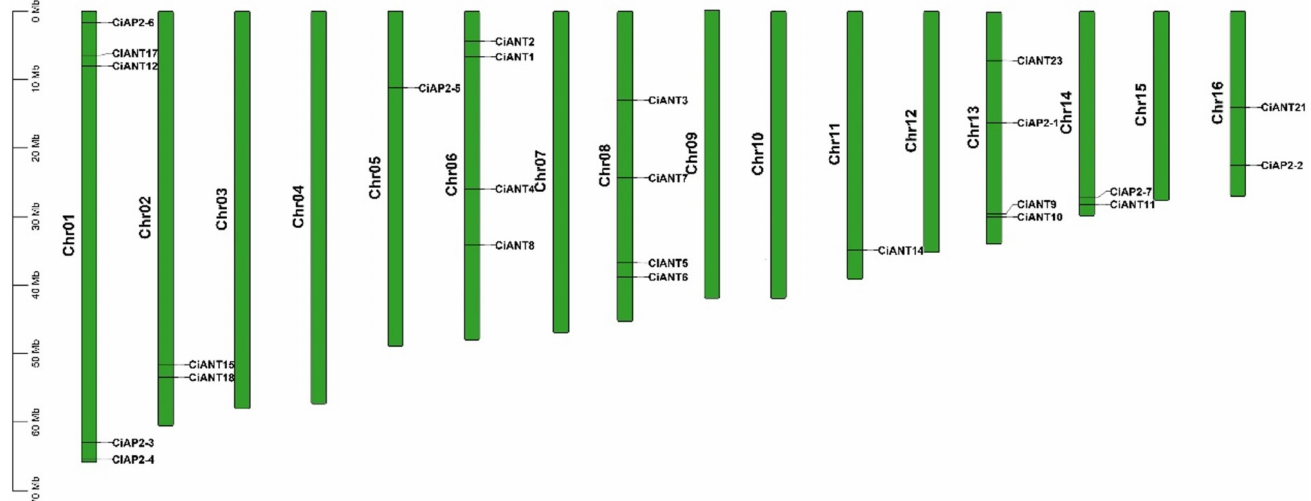
Figure 1. The distribution of the AP2 subfamily genes on pecan chromosomes. The position of each CiAP2 was mapped according to its physical position on the pecan genome. The chromosome number is labeled at the right of each chromosome, and the scale is in mega bases (Mb).